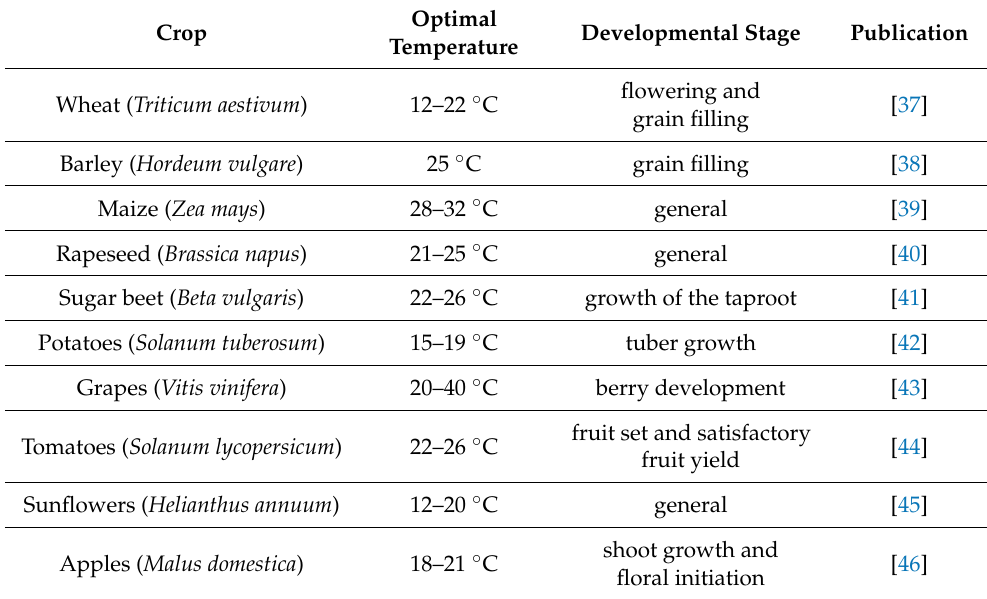
Table 1. Optimal temperature conditions for the principal European